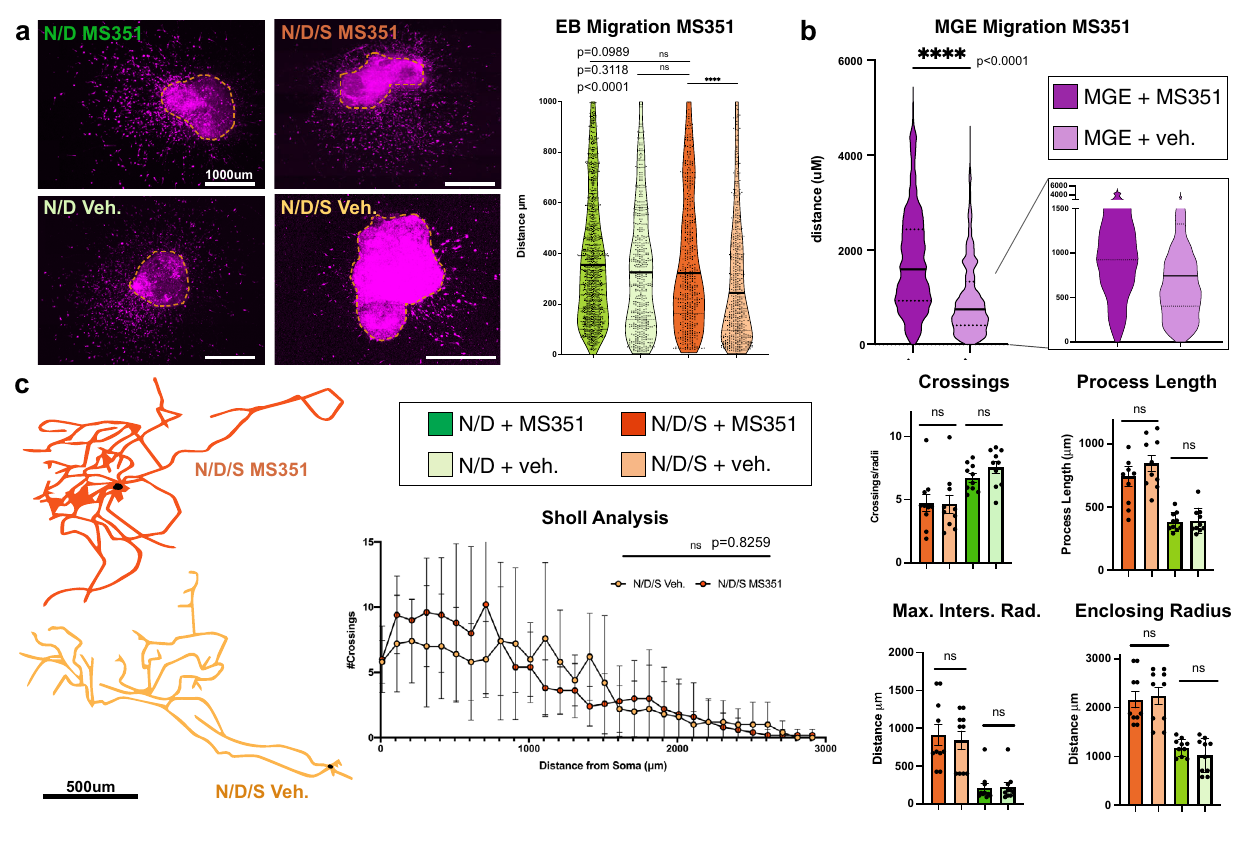
Fig. 7 | St18 regulates projection neuron migration but not morphology via upregulation of Cbx7. a Sample images of Matrigel embedded N/D/S EBs treated either with MS351 orVeh. Ai9 tdtTomato in magenta.Quanti fi cation to the right of the images (Mann – Whitney U Test; N/D/S MS351 vs. vehicle p =0.0000146). Dataset represents 3 EBs per condition; 531N/D/S MS351 cells and 614N/D/S Veh. cells and 1301N/D MS351 cells and 567N/D Veh. cells. b MGE explants from